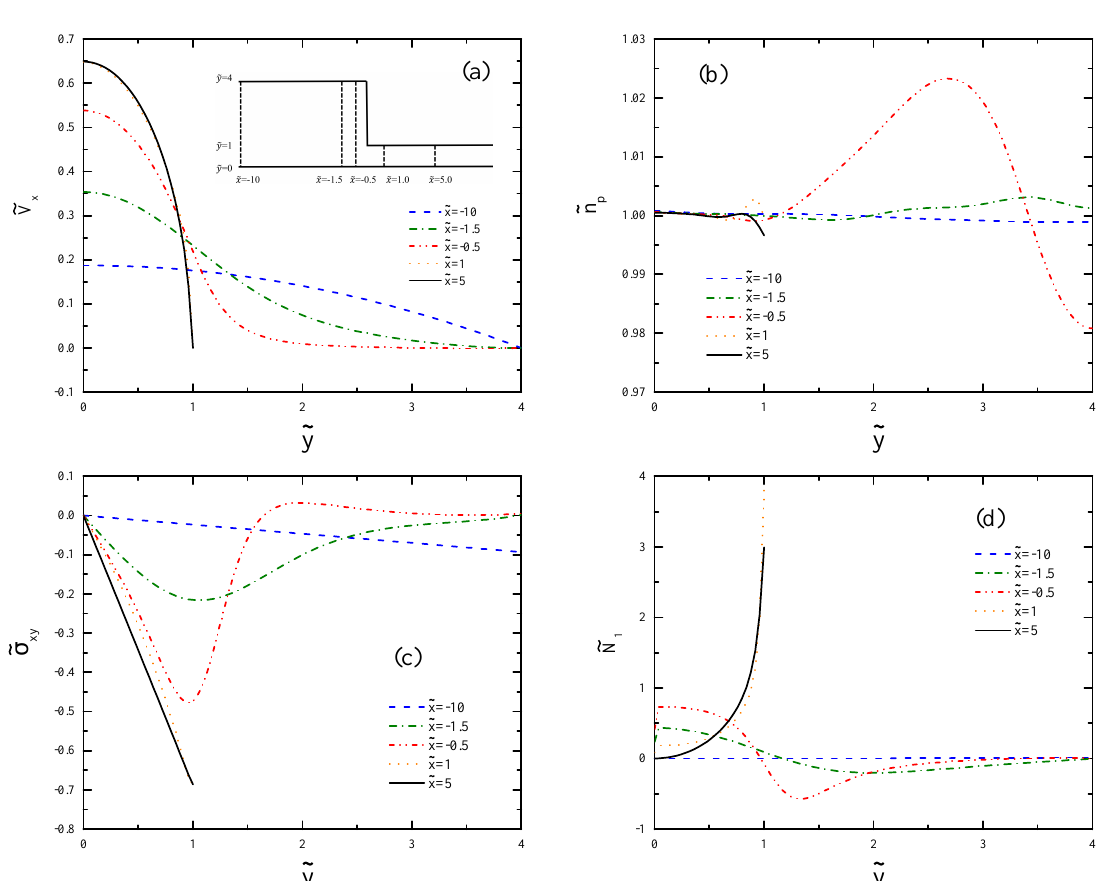
Figure 8. Profiles of ( a ) axial velocity, ( b ) polymer number density, ( c ) shear stress, and ( d ) first normal stress difference for De = 0.5 at vertical cross-sections ˜x = − 10, − 1.5, − 0.5, 1.0, and